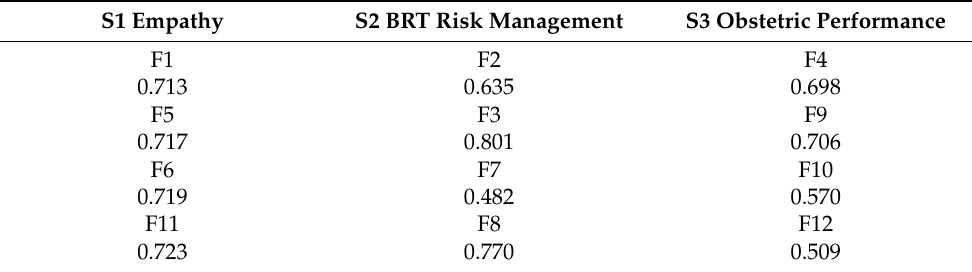
Table 4. Second order EFA; F1, supremacy; F2, obstetric complicactions; F3, Psychological risks; F4, Pain management; F5, Humanization; F6, women’s decision making; F7, birth-reñlated- trauma etilology; F8, Psychosocial risk; F9, Obstetric practice; F10, accompaniment; F11, com- mitment; F12, women’s expectations; S1, Ability to empathize; S2, BRT-risk management; S3, Obstetric performance.